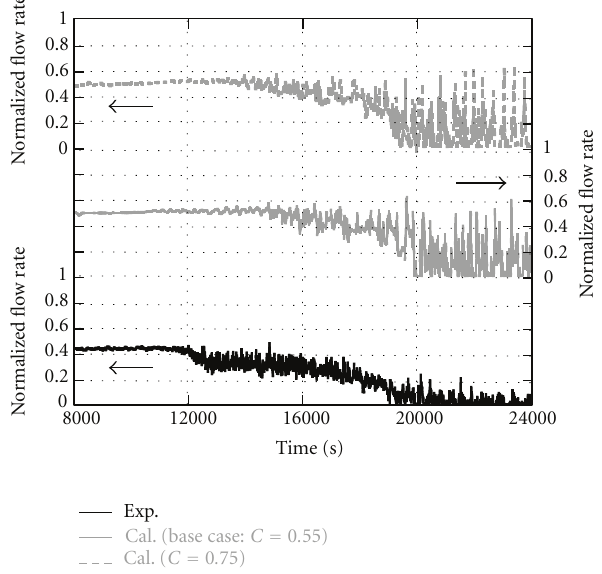
Figure 29: RELAP5 results for primary mass flow rate in loop with PZR in cases with di ff erent constants C of Wallis CCFL correlation at both all PZR and surge-line junctions.